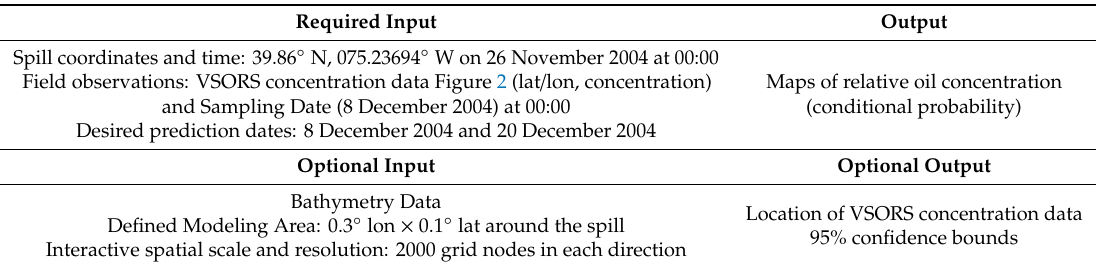
Table 2. Inputs and outputs for demonstration of M / T Athos I oil spill.